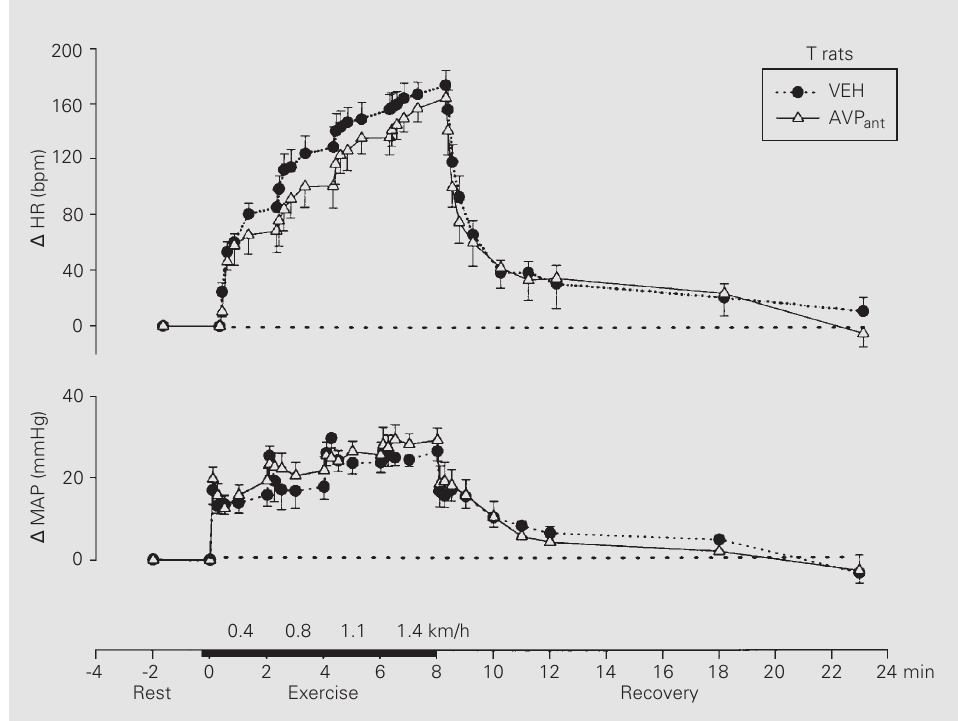
Figure 5 - Heart rate (HR) (upper panel) and mean arterial pres- sure (MAP) responses (lower panel) during progressive exer- cise (0.4 up to 1.4 km/h) in 7 trained rats pretreated with ve- hicle (VEH) or a V 1 blocker (AVP ant ) into the NTS. Repro- duced from Ref. 40, with per-